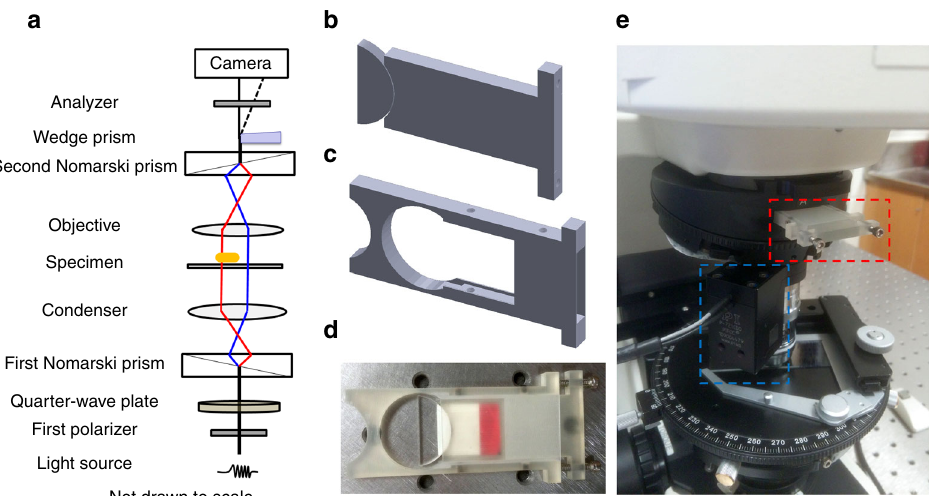
Fig. 2 Parallax-DIC microscope and 5D-SPT instrumental set-up. a Schematic illustration of the optical path in parallax-DIC microscope. High-precision objective scanner was not drawn in the scheme. b Model of the insert mounted with the custom-cut wedge prism. c Model of the slot. d Photograph of the wedge prism set installed on the 3D-printed insert housing in the 3D-printed slot. The position of the insert and wedge prism were optimized and fi xed by four #4/40× 1/8 socket set screws and two #4/40× 1/2 hex socket head cap screws to split the light in half at the back focal plane of the objective. e Photograph of the 5D-SPT instrumental set-up. The optimized wedge prism set was insert to the light path (as indicated in the red dashed box) to enable the parallax-DIC mode and the objective scanner (as shown in the blue dashed box) was use to deploy the automated Supplementary Fig. 4. To ensure suf fi ciently high-angular resolution and localization precision in live cells, the 40 × 80 nm gold nanorod sample and the exposure time of 33 ms were employed in most of the 5D-SPT experiments reported in this paper, unless otherwise noted. The precision measurements of the 3D localization yield standard deviations of 11, 14, and 17 nm in the x , y , and z axes, respectively (Fig. 1d and Supplementary Fig. 5). The evaluation of the autofocusing under the parallax- DIC microscope is shown in Supplementary Fig. 6.